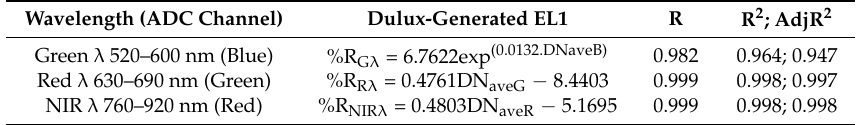
Table 7. OLS equations (EL1) of camera response function per waveband for Spectralon